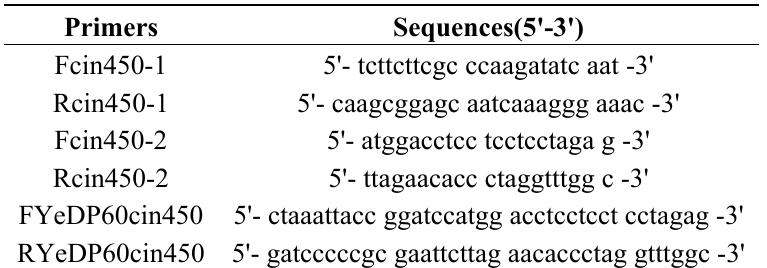
Table 1. Primers used in gene isolation and plasmid